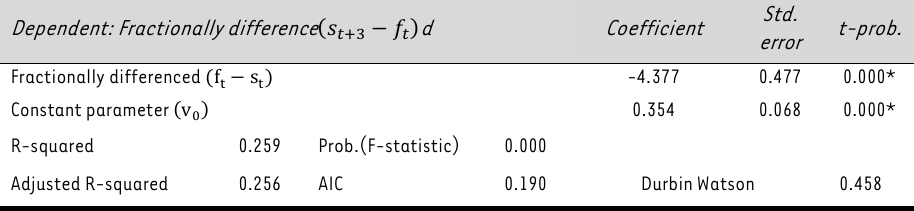
The forward premium hypothesis – fractionally differenced approach